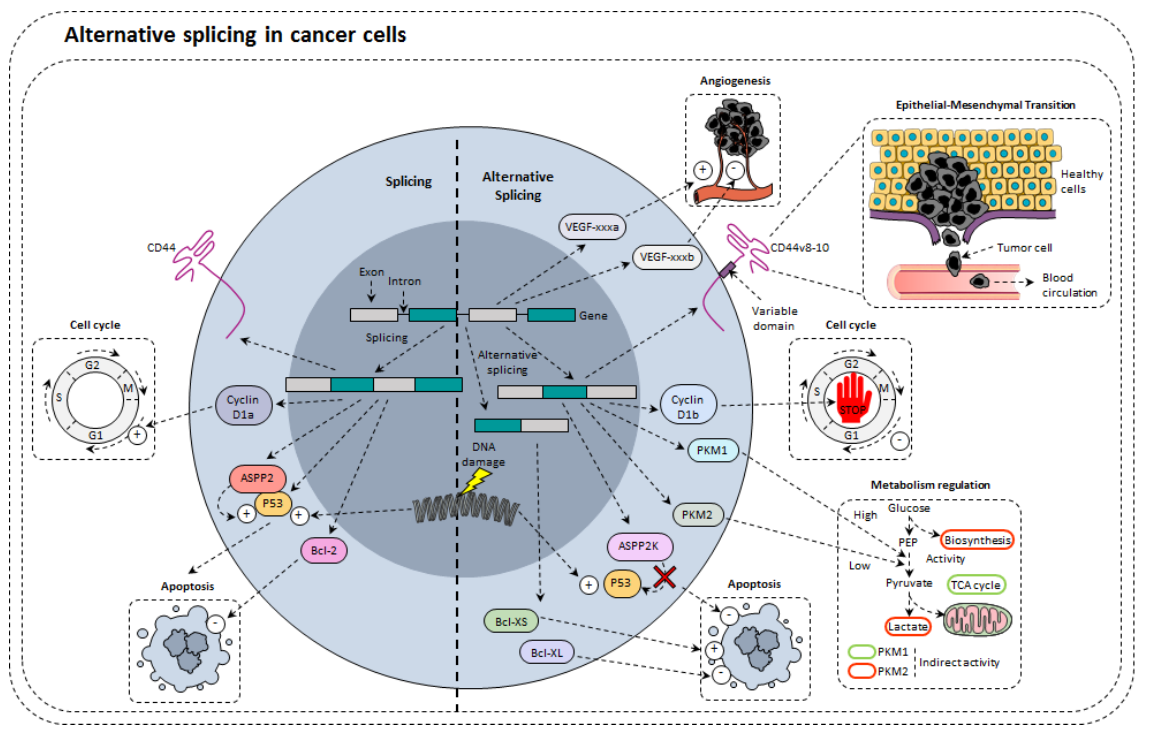
Figure 3. Alternative splicing in cancer cells. Impact of splicing (left part) and alternative splicing (right part) in a cancer cell.